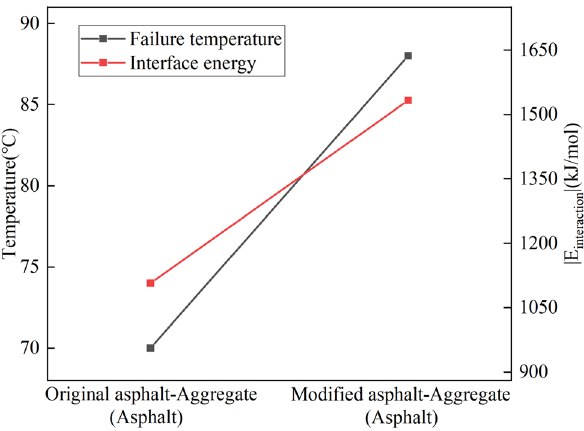
Figure 22: Veri fi cation of DSR test results and simulation results.